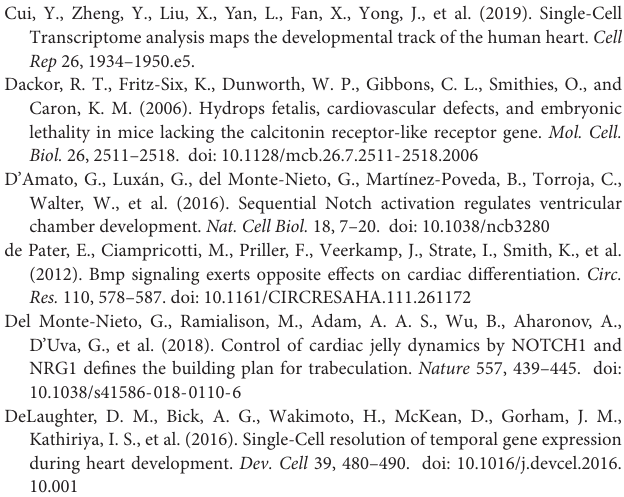
Supplementary Figure 2 | (A) UMAP split according to sample (CM Monoculture, EC Monoculture, and EC-CM Co-culture. (B) EC, CM, cell cycle and mesenchymal cell gene expression in the defined clusters. All scRNAseq data presented in the figure consists of combined data from HEL47.2 and HEL24.3 lines. Supplementary Figure 3 | Comparison of hiPS transcriptomics between HEL47.2 and HEL24.3 lines. (A) Samplewise distribution of cells per cluster. Distribution of cells per cell type cluster according to sample in (B) hiPS-CM, (C) hiPS-EC in co-culture, (D) hiPS-EC in monoculture. Supplementary Figure 4 | Co-culture vs. monoculture hiPS-EC expression of (A) genes related to heart development, (B) cardiac EC genes, and (C) genes coding for junctional proteins and their regulators. All scRNAseq data presented in the figure consists of combined data from HEL47.2 and HEL24.3 lines. Supplementary Figure 5 | Changes in the expression of BMP, Notch and VEGF pathway genes. (A) Clusterwise expression of BMP-, Notch-, and VEGF-pathway ligands included in TOP 20 hiPS-CM sender gene list and other BMP- and Notch-ligands that had higher expression in co-culture hiPS-ECs. hiPS-CM and co-culture hiPS-EC clusters are highlighted. Clusterwise expression of (B) BMP-, Notch-, and VEGF-pathway receptors and (C) BMP- and Notch-pathway targets in monoculture and co-culture hiPS-ECs. All scRNAseq data presented in the figure consists of combined data from HEL47.2 and HEL24.3 lines. Supplementary Figure 6 | Ligand-target gene analysis. (A) Expression of top ligands in sender cells (hiPS-EC). (B) Ligand–target matrix denoting the regulatory potential between sender (hiPS-EC) ligands and predicted receiver (hiPS-CM) target genes. (C) Ligand-receptor interactions between ligands from hiPS-ECs and receptors expressed in hiPS-CMs. All data presented in the figure consists of combined data from HEL47.2 and HEL24.3 lines. Supplementary Figure 7 | Clusterwise expression of ErbB-pathway ligands and receptors. hiPS-CM and co-culture hiPS-EC clusters are highlighted. All scRNAseq data presented in the figure consists of combined data from HEL47.2 and HEL24.3 lines. Supplementary Figure 8 | Clusterwise expression of (A) BMP-, (B) Notch-, and (C) ErbB-pathway genes presented separately in the HEL47.2 and HEL24.3 lines. Supplementary Figure 9 | Results from the independent replication including six pooled hiPS-EC/hiPS-CM co-culture samples. (A) The UMAP of the pooled cells. (B) Expression of cardiac contractility genes and cardiac secreted protein NPPA coding gene in the EC and CM clusters. Co-culture hiPS-EC expression of (C) genes related to heart development and endocardial genes (the same genes as presented in Supplementary Figures 4A,B ), and (D) BMP-, Notch- and ErbB-pathway genes (the same genes as presented in Supplementary Figures 8A–C